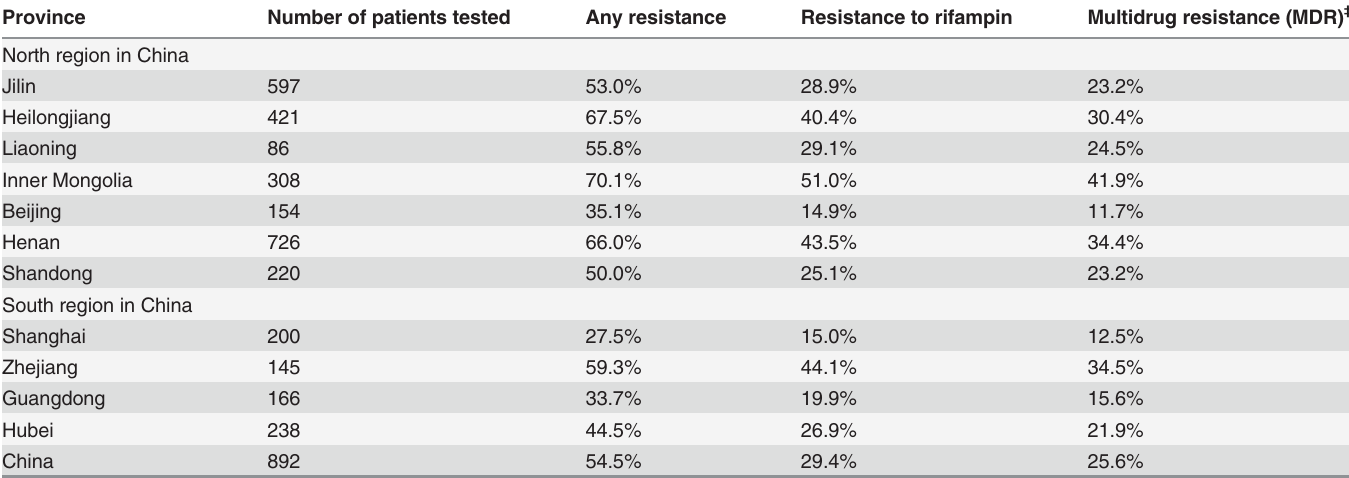
Table 5. Proportion of drug resistance in re-treated tuberculosis cases tested in 11 Chinese